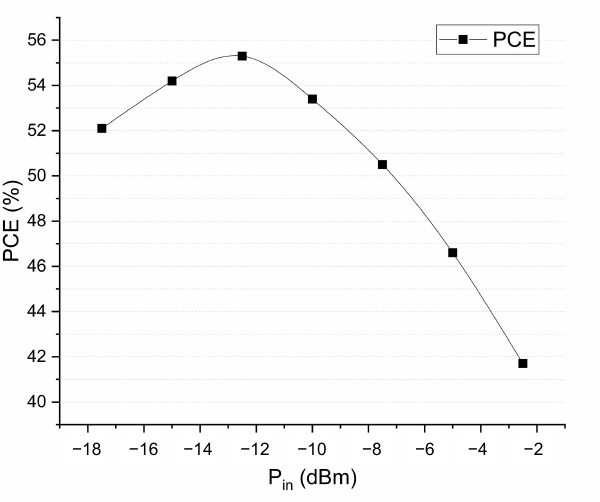
Figure 18. PCE of proposed RF energy harvesting